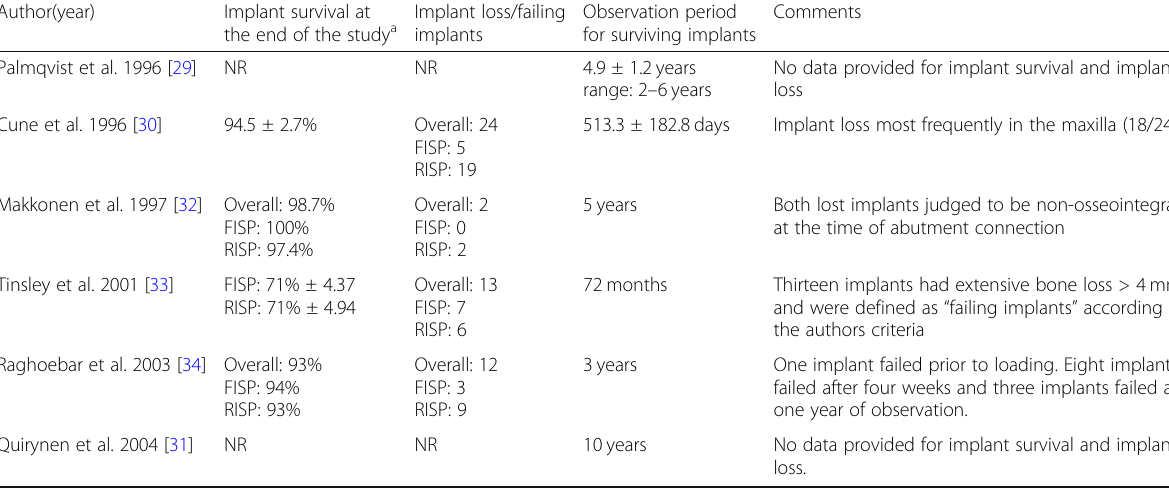
Table 7 Implant survival characteristics in the included